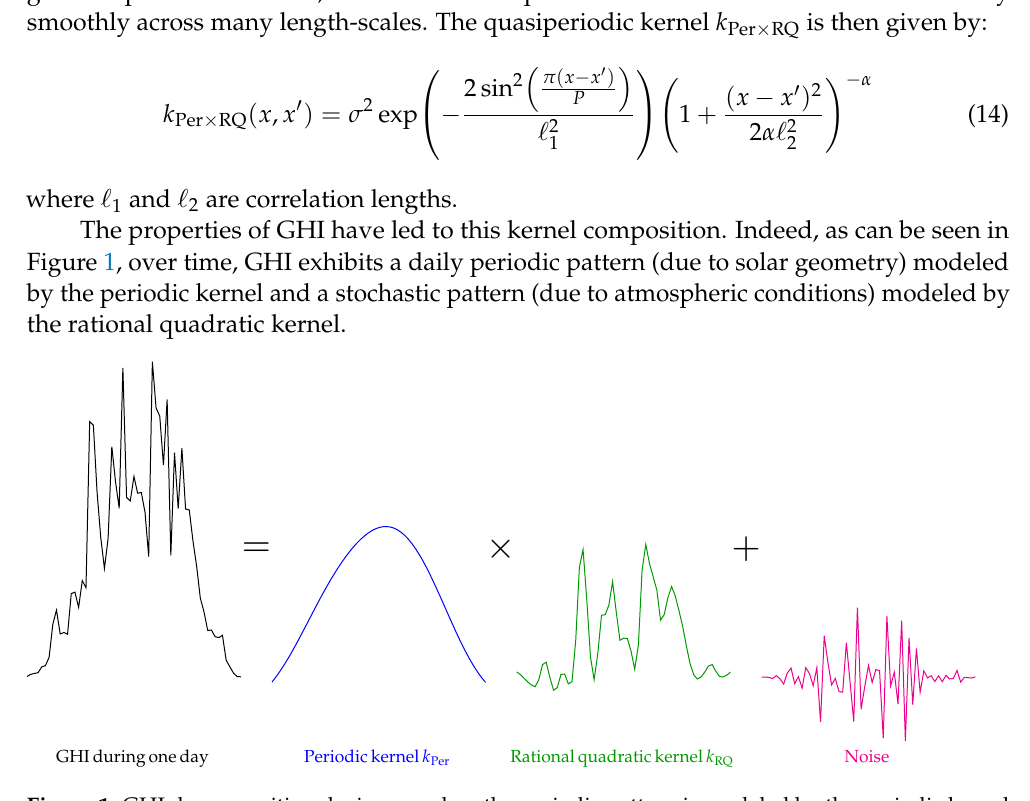
Figure 1. GHI decomposition during one day: the periodic pattern is modeled by the periodic kernel and the stochastic pattern is modeled by the rational quadratic kernel.